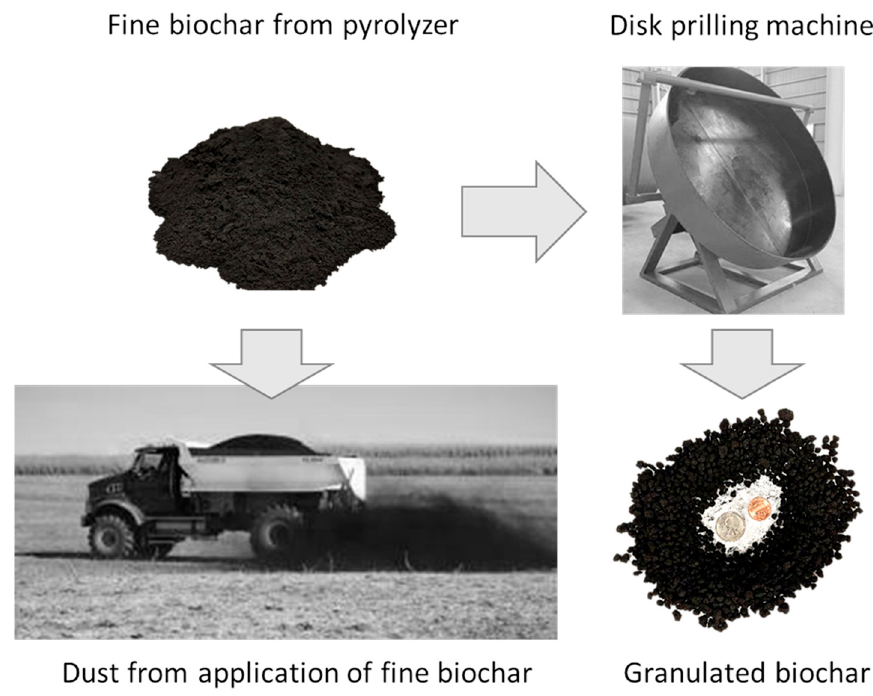
Figure 8. Fine biochar from many kinds of pyrolyzers is problematic in field application, which can be mitigated through prilling to granular biochar.